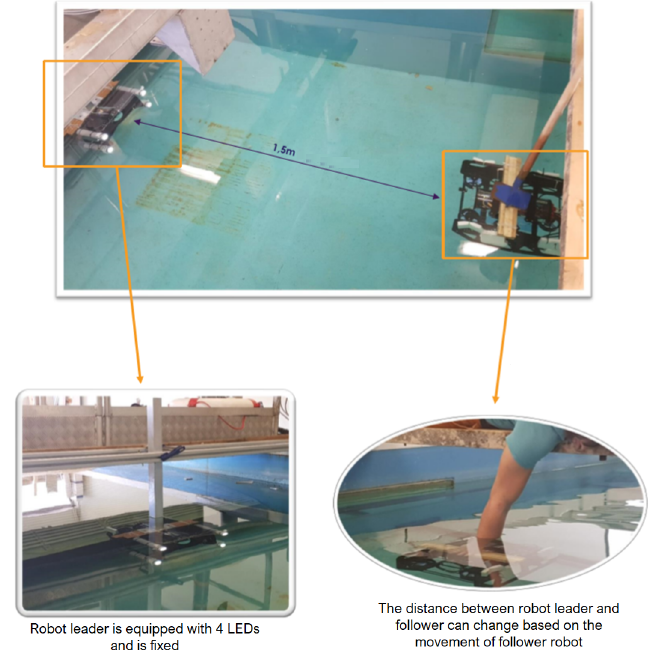
Figure 12. Determination of the real distance between two robots by using a camera.